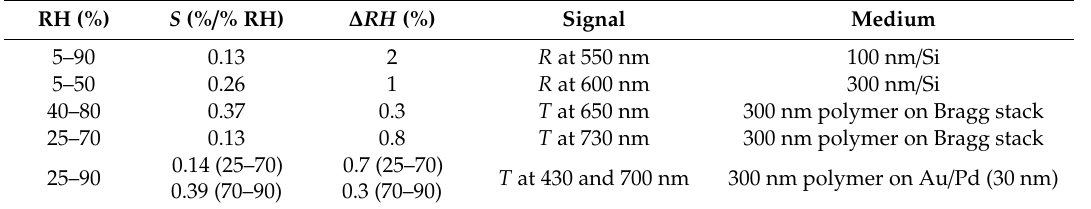
Table 1. Dynamic range, RH, sensitivity, S , and resolution, ∆ RH , calculated from Equations (1) and (2), respectively, measured signal type for detection, and sensitive